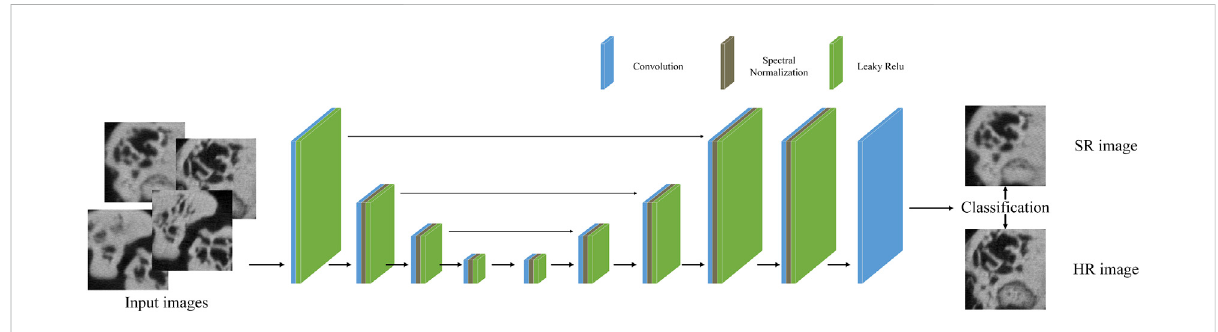
FIGURE 3 U-Net discriminator with